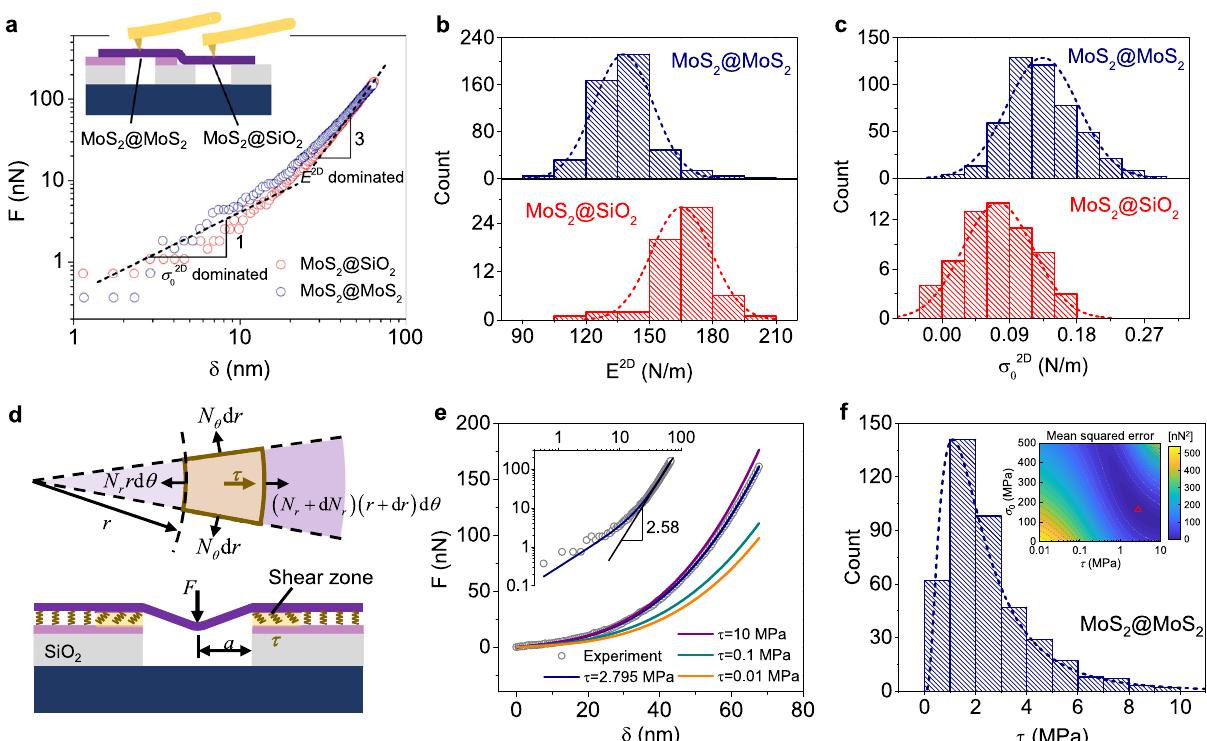
Fig. 3 Determination of shear stress at TBLM interfaces with the shearing-boundary model. a Typical force-indentation depth ( F - δ ) curves of MoS 2 @MoS 2 (blue dots) and MoS 2 @SiO 2 (red dots) in logarithmic coordinates. The inset shows a schematic diagram of MoS 2 @MoS 2 and MoS 2 @SiO 2 . b , c Histograms of the in-plane elastic modulus ( E 2D ) and pretension ( σ 0 2D ) of all samples measured over 1- μ m-diameter and 1.5- μ m-diameter holes. Here, MoS 2 @MoS 2 samples exhibit smaller E 2D and larger σ 0 2D than MoS 2 @SiO 2 samples. The dashed lines represent the fi tting curves based on Gaussian distribution. d Schematic illustrations of the nanoindentation process on a 2D membrane and the proposed theoretical model that considers an interfacial shear zone between the tested membrane and the substrate. The in-plane equilibrium analysis for a representative element is illustrated in the top part. N r and N θ are the radial and circumferential stress resultants, respectively. r is the distance between the selected element and the center of the hole. d θ is the angle of the sector. a is the radius of the hole. e Comparison between one typical experimental curve and fi tted curves based on Eq. (2). The inset is the fi tting curve based on τ = 2.795 MPa, suggesting that when the interlayer shear stress τ = 2.795 MPa, the fi tting error reaches a minimum. f Distribution of fi tted shear stresses that satis fi es a logarithmic normal distribution. The inset shows a contour map of the nonlinear fi tting error to obtain the closest shear stress of this